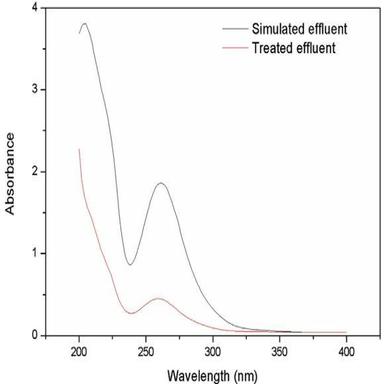
UVeVis spectra of simulated pharmaceutical effluent (black) and treated pharmaceutical effluent (red) with NiAC (25 mg L1 of ibuprofen, 25 mg L1 of ketoprofen, 100 mg L1 of sodium chloride and 100 mg L1 of sodium bicarbonate, adsorbent dosage of 0.5 g L1 , 298 K, 125 rpm, 4 h, pH 2). (For interpretation of the references to color in this figure legend, the reader is referred to the Web version of this article.)